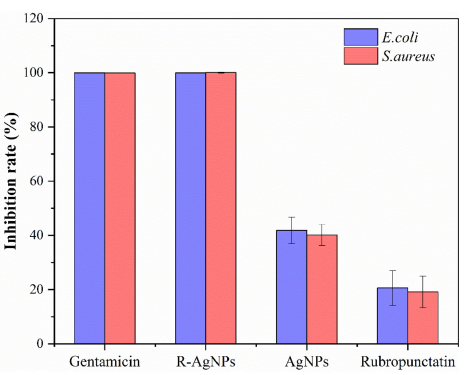
Figure 7. Inhibition ratio of R-AgNPs at 2MIC against E. coli and S. aureus . AgNPs, rubropunctatin and gentamicin were investigated for comparison.